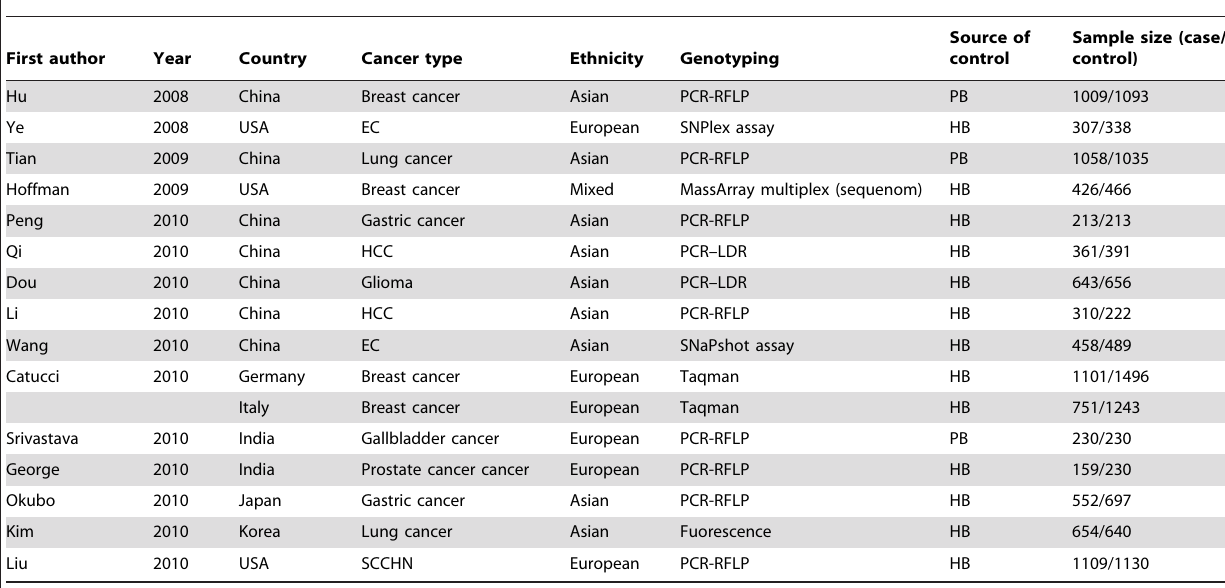
Table 1. Characteristics of literatures included in the meta-analysis.